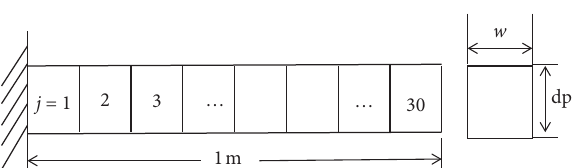
Figure 2: The cantilever beam is discretized in 30 Euler–Bernoulli